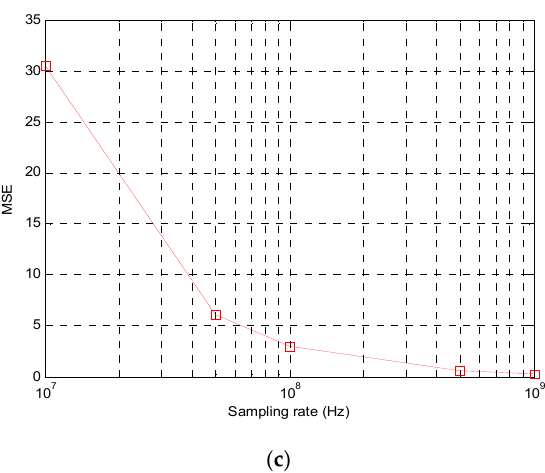
Figure 13. MSE curves of the estimated distance for ( a ) the first case, ( b ) the second case, and ( c ) the third case, for the second set.